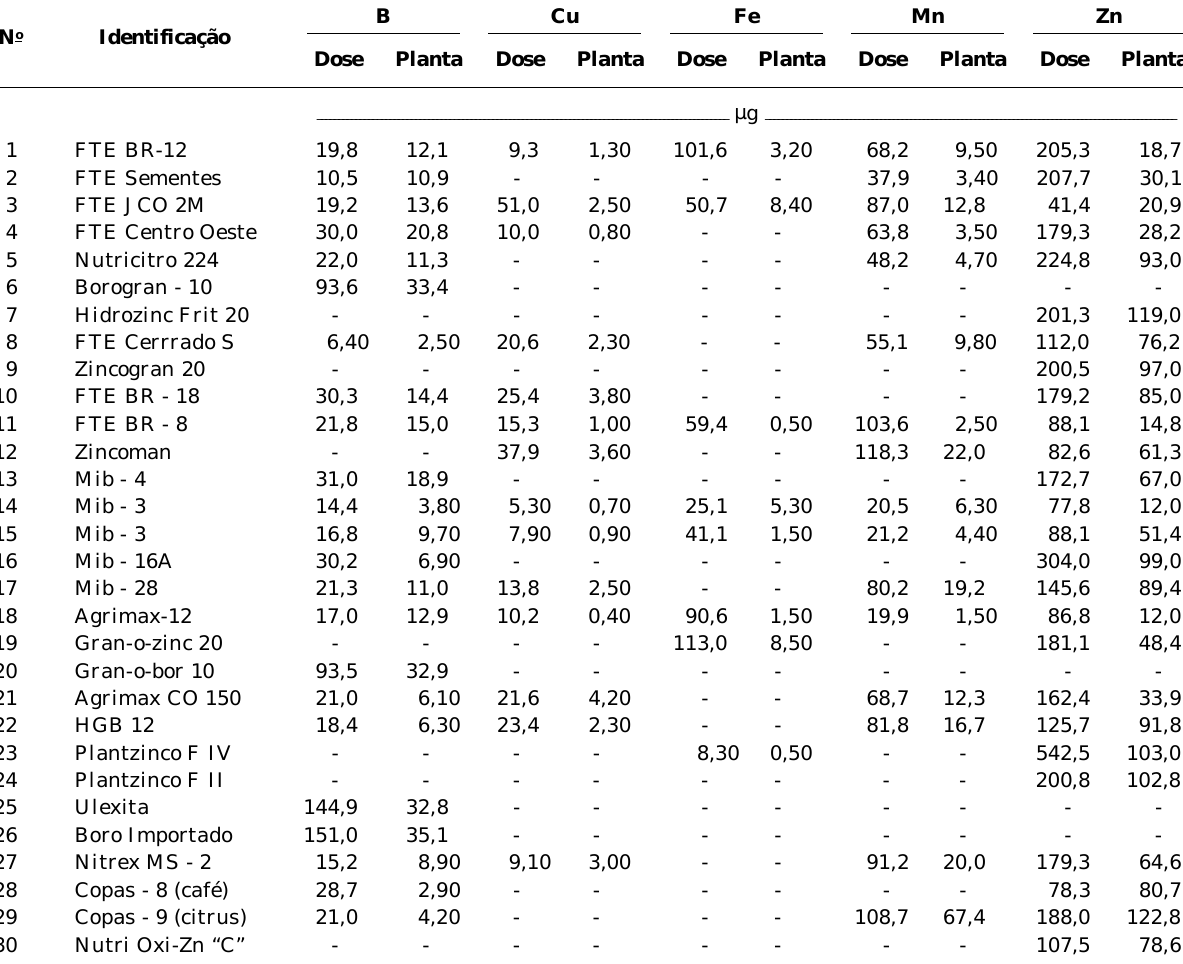
Quadro 2. Dose de cada micronutriente fornecido e teores acumulados por plantas de arroz, pelo